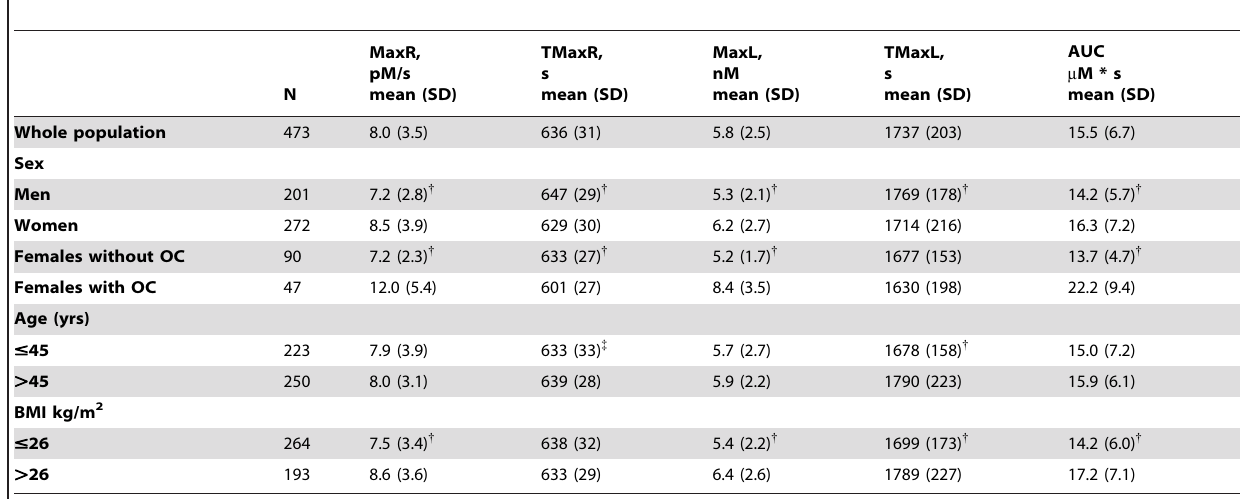
Table 2. Factor Xa generation outputs for healthy controls (no known